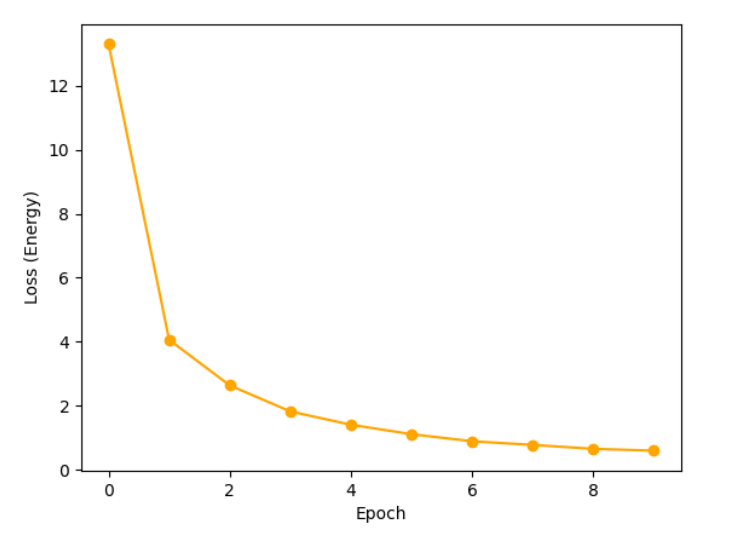
Figure 15. Energy loss when training the unfactored gated RBM from Memisevic and Hinton [10].